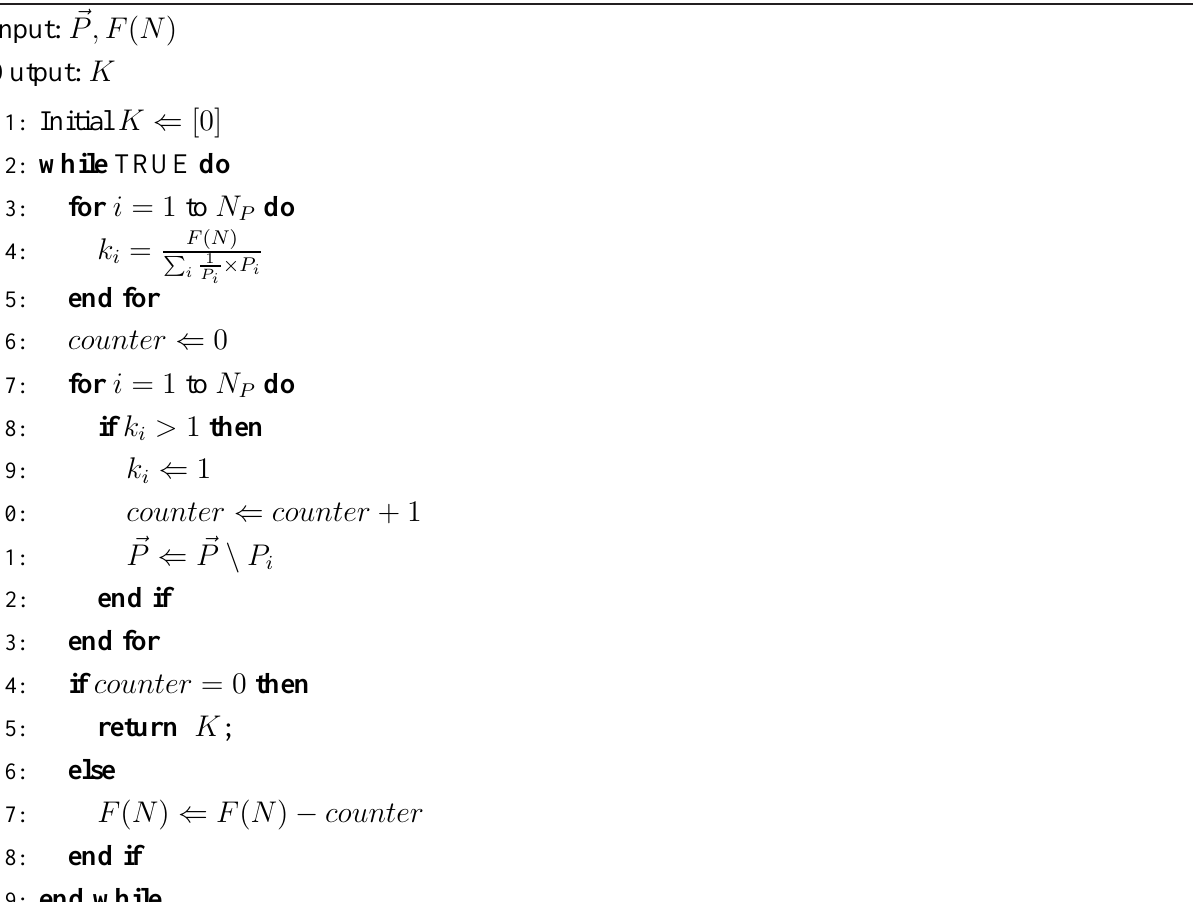
Algorithm 1 Optimization